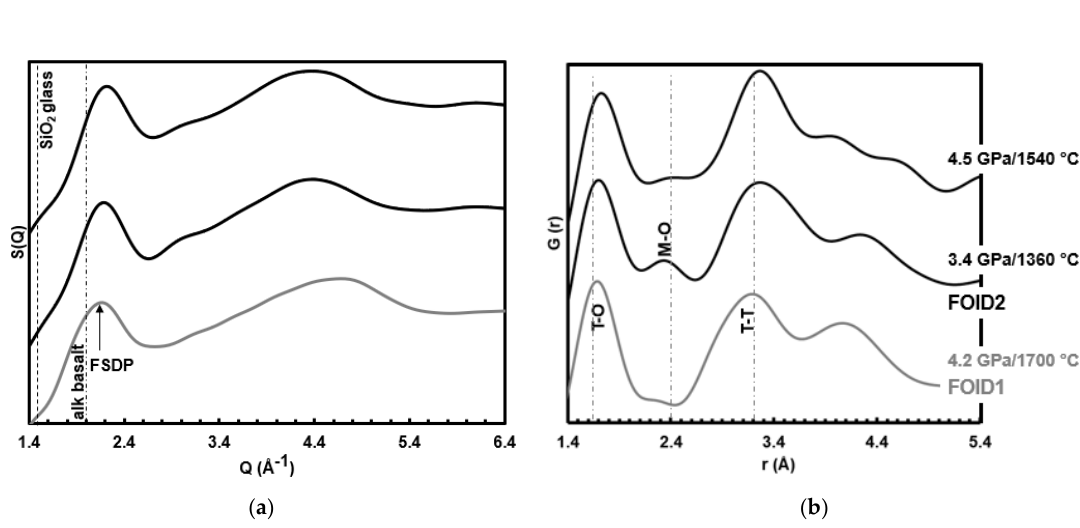
Figure 3. ( a ) Structure factor, S(q), and ( b ) the reduced pair distribution function G(r) measured at high P – T, using the multi-angle energy-dispersive X-ray diffraction technique on FOID1 (gray line) and FOID2 (black line) compositions. Dashed lines are references for the known FSDP position and atomic distances from literature (see text).